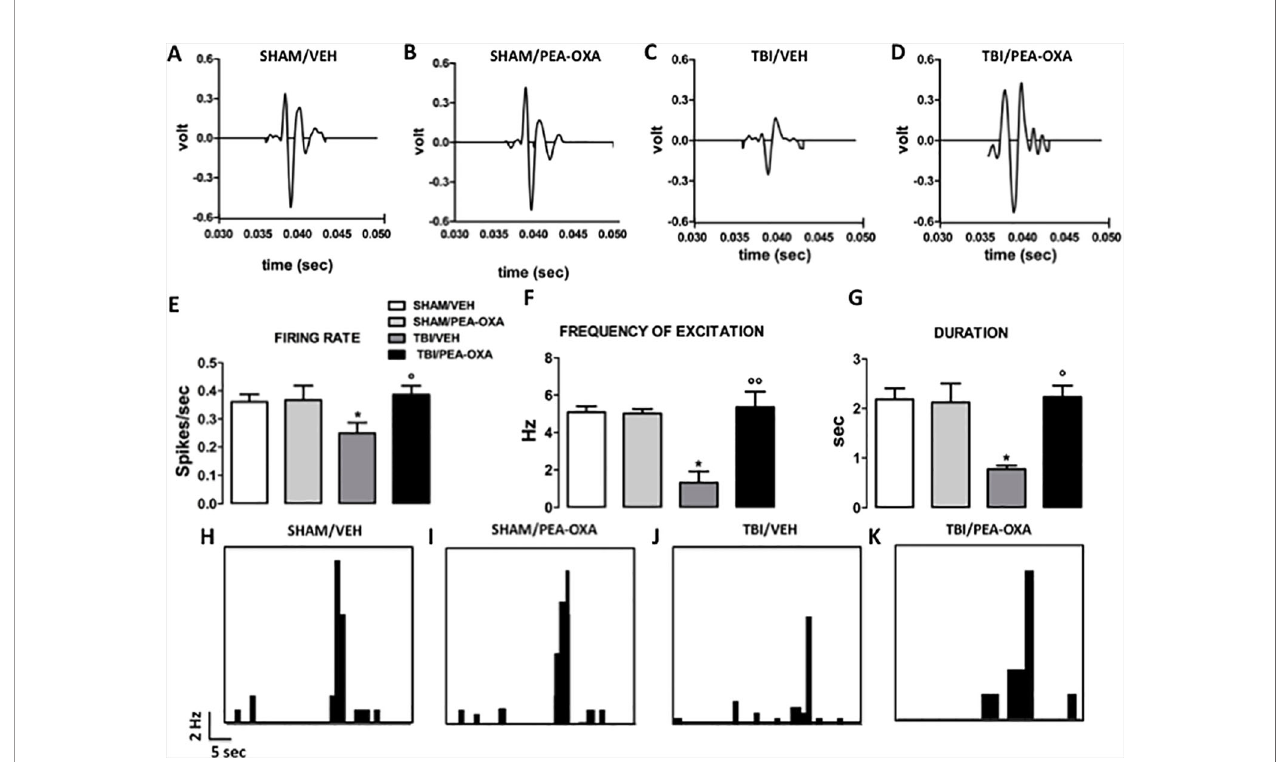
FIGURE 5 | Effects of repeated administration of vehicle (Kolliphor 5%) or PEA-OXA (10 mg/kg, i.p.) on spontaneous and mechanical stimulus-evoked excitation of single m PFC (+) neuron in SHAM and TBI mice 60 days after trauma (A – D) Representative action potential of single m PFC (+) neuron SHAM and TBI mice treated with vehicle or with PEA-OXA, (E – G) Mean of spontaneous activity, of the frequency and of the duration of excitation, respectively, in different groups of mice, (H – K) . Representative PSTHs of m PFC (+) neuron of SHAM and TBI mice 60 days post trauma treated for 60 days with vehicle or PEA-OXA. Data are represented as mean ± SEM of six to eight mice per group. *P < 0.05 indicate signi fi cant differences compared to SHAM/veh. °P < 0.05 and °°P < 0.01 indicate signi fi cant differences compared to TBI/veh. P < 0.05 was considered statistically. One-way ANOVA, followed by Bonferroni post hoc test was